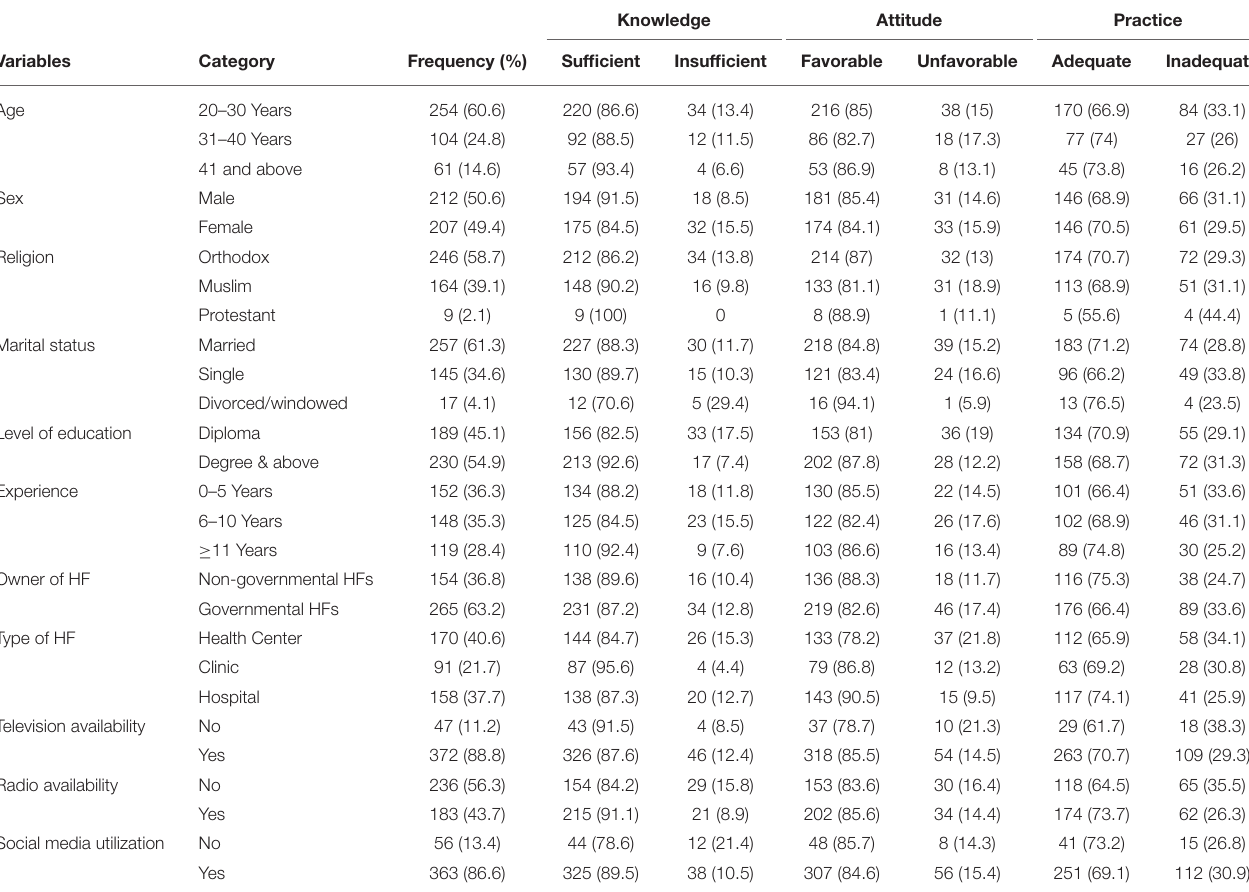
TABLE 1 | Sociodemographic characteristics of health professionals in Dessie city, northeast Ethiopia ( N =